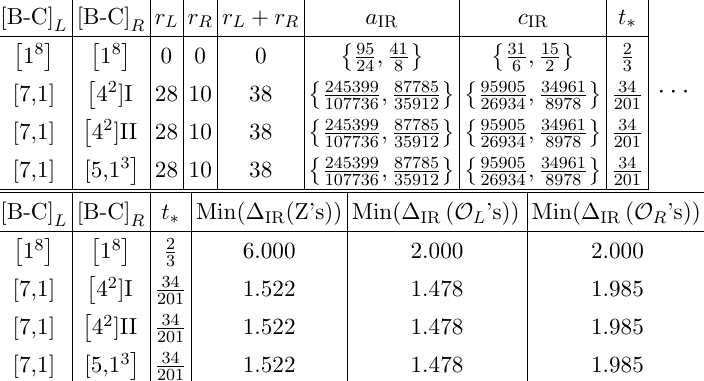
Table 20. Flipper (cid:12)eld deformations of ( D 4 , D 4 ) conformal matter, only rational values.